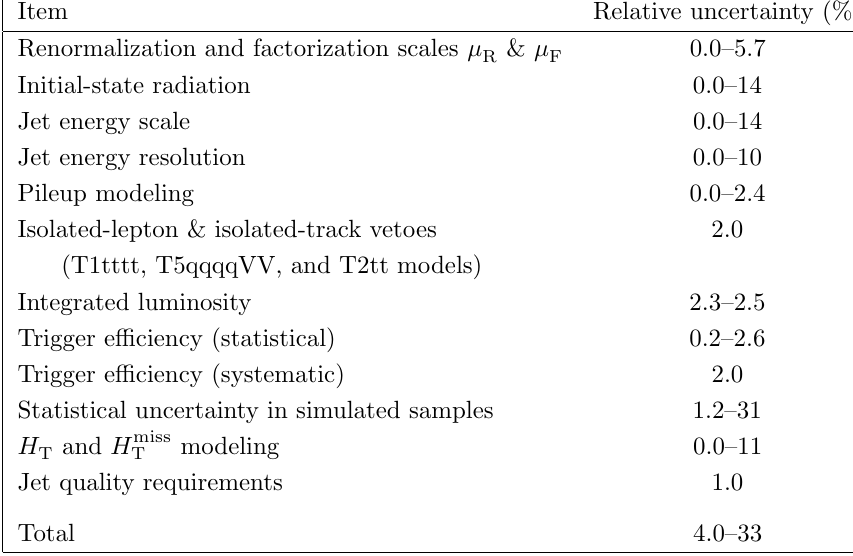
Table 2 . Systematic uncertainties in the yield of signal events, averaged over all search bins. The variations correspond to di(cid:11)erent signal models and choices for the SUSY particle masses. Results reported as 0.0 correspond to values less than